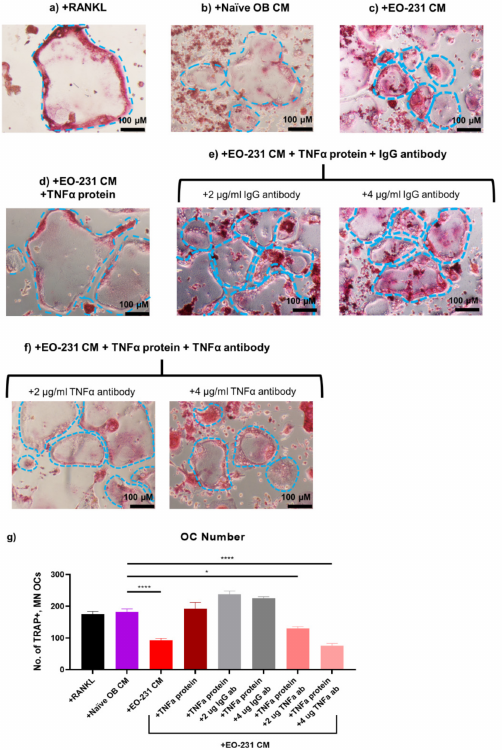
Figure 8. EO-231-altered Osteoclast Formation can be Modulated by TNF α . RAW 264.7 pre- osteoclasts were cultured in the presence of ( a ) 50 ng/mL exogenous RANKL, or cultured in the presence of 50 ng/mL exogenous RANKL and exposed for six days to ( b ) naïve OB CM (control) or ( c ) EO-231 CM. RAW 264.7 pre-osteoclasts cultured in the presence of 50 ng/mL exogenous RANKL and exposed to EO-231 CM plus ( d ) recombinant TNF α protein (12 ng/mL) or ( f ) recombinant TNF α protein (12 ng/mL) plus TNF α antibody (2 µ g/mL or 4 µ g/mL) for six days. ( e ) RAW 264.7 pre-osteoclasts were exposed to EO-231 CM in the presence of recombinant TNF α protein (12 ng/mL) plus polyclonal IgG antibody (2 µ g/mL or 4 µ g/mL) in the presence of 50 ng/mL exogenous RANKL for six days as a control. After six days, cultures were stained for tartrate resistant acid phosphatase (TRAP; pink color; blue outlines), a common marker for mature osteoclasts. The number (No.) of TRAP-positive, multinucleated ( ≥ 3 nuclei) mature osteoclasts were quantified for each condition ( g ). Scale = 100 µ M. N = 3. * p < 0.05; **** p <